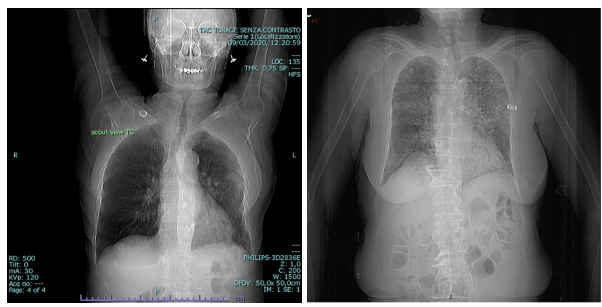
Figure 15. Example of bad projection of lungs.